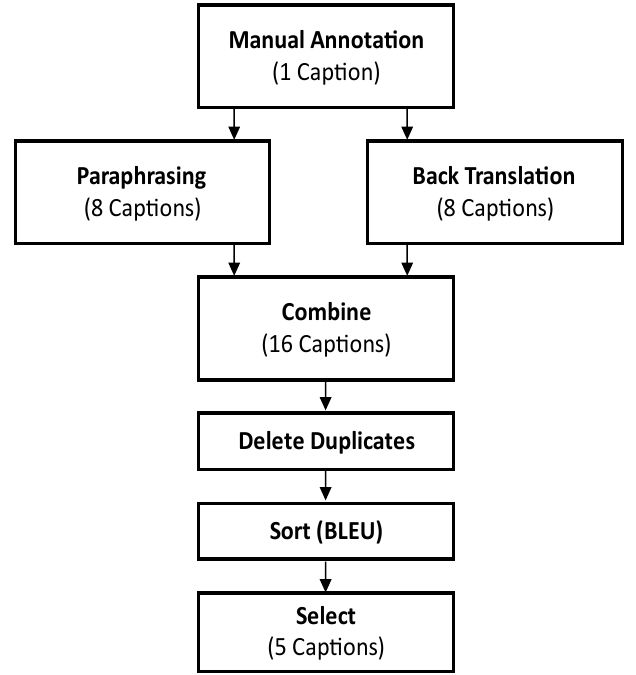
Figure 1. Pipeline for constructing CapERA dataset.